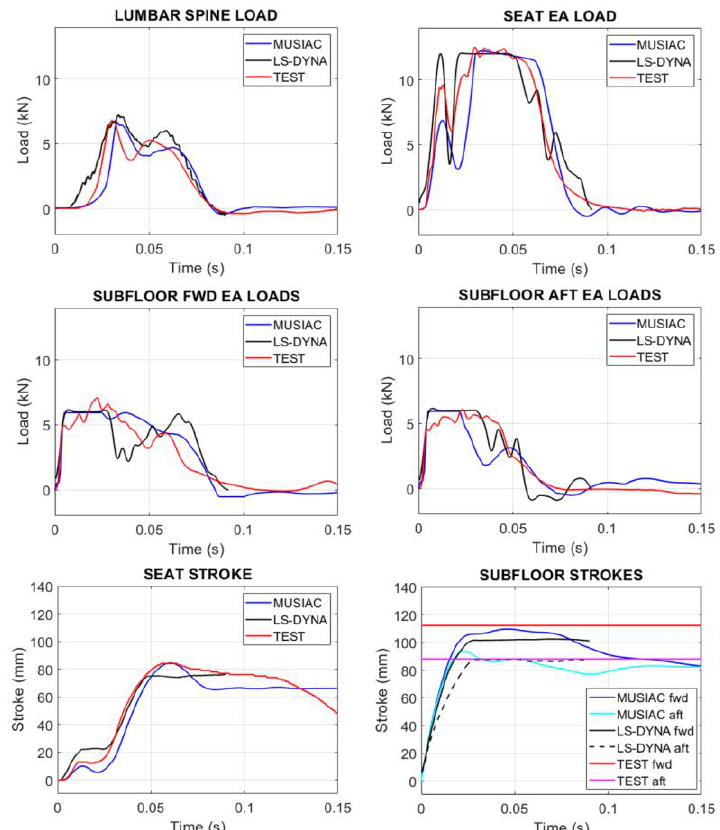
Figure 11. Main test results and comparison with finite element (LS-Dyna) and lumped parameters (MUSIAC) results; the subfloor residual strokes are only reported for the test as flat horizontal lines.